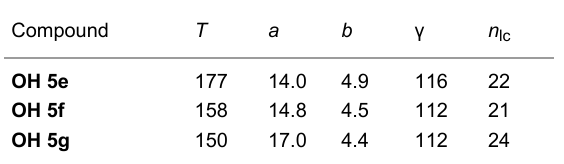
Table 6: Structural parameters for the modulated-layer phases of com- pounds OH 5e , 5f and 5g: Temperature, T (°C) on cooling, 2D lattice parameters a , b (nm), and γ (°), molecules in the cross section of the unit cell n lc